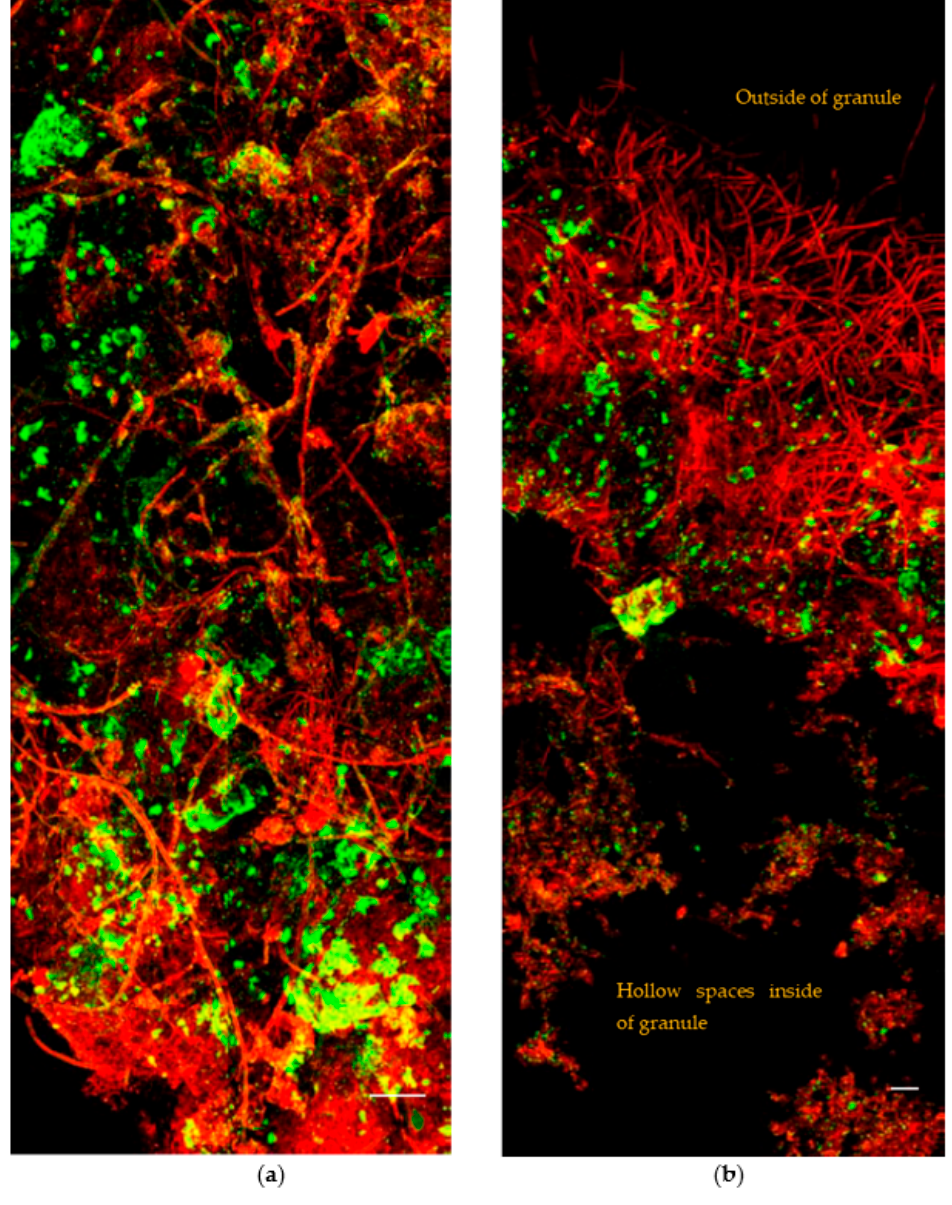
Figure 4. Distribution of bacteria (red) and EPS (green) in large granules (diameter > 6 mm). ( a ) Surface of a large granule; ( b ) partial cross-section of a large granule. Scale bar = 50 μ m.